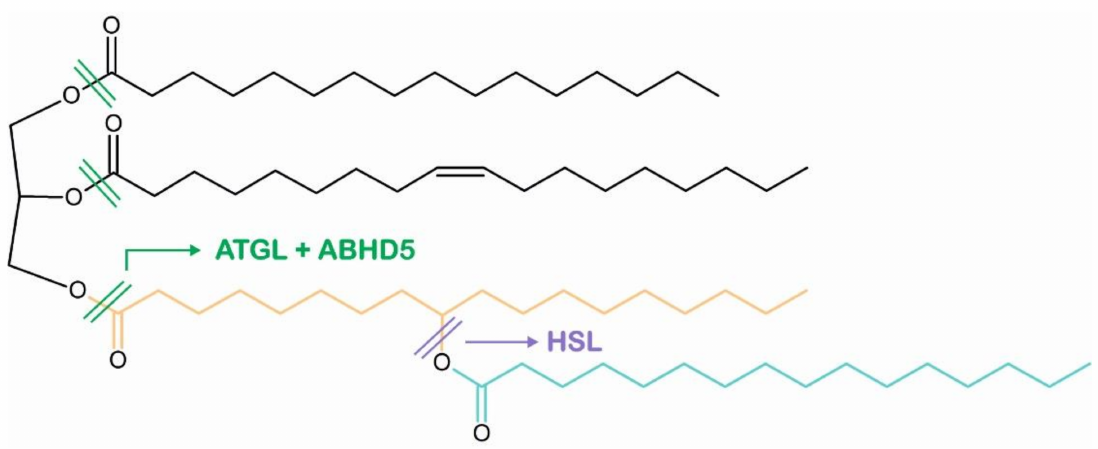
Figure 4. Molecular structure of triacylglycerol estolide. Adipose triglyceride lipase (ATGL, co- activated by α / β hydrolase domain containing protein 5, ABHD5) and hormone-sensitive lipase (HSL) show different substrate specificities towards ester bonds in triacylglycerol estolide molecules as indicated by